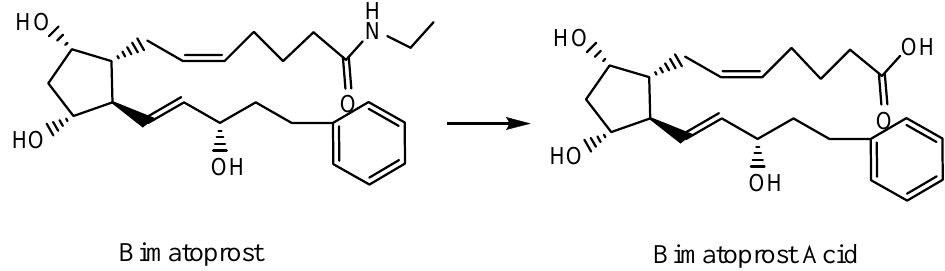
Figure 2. Bimatoprost prodrug and its hydrolysis to the active form, bimatoprost acid, in the